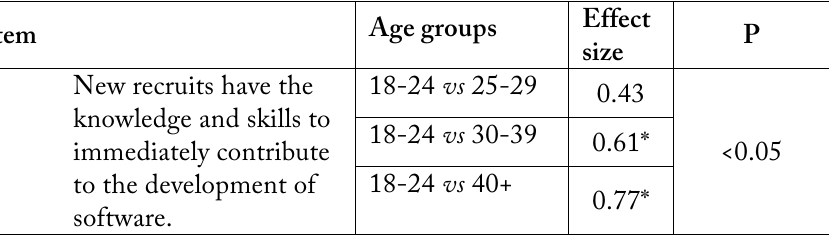
Table 6: Differences between the age